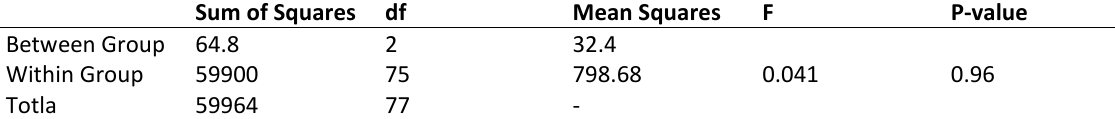
Table 3. One-way ANOVA results of Athletes` performance with different levels physical cycle Sum of Squares df Between Group